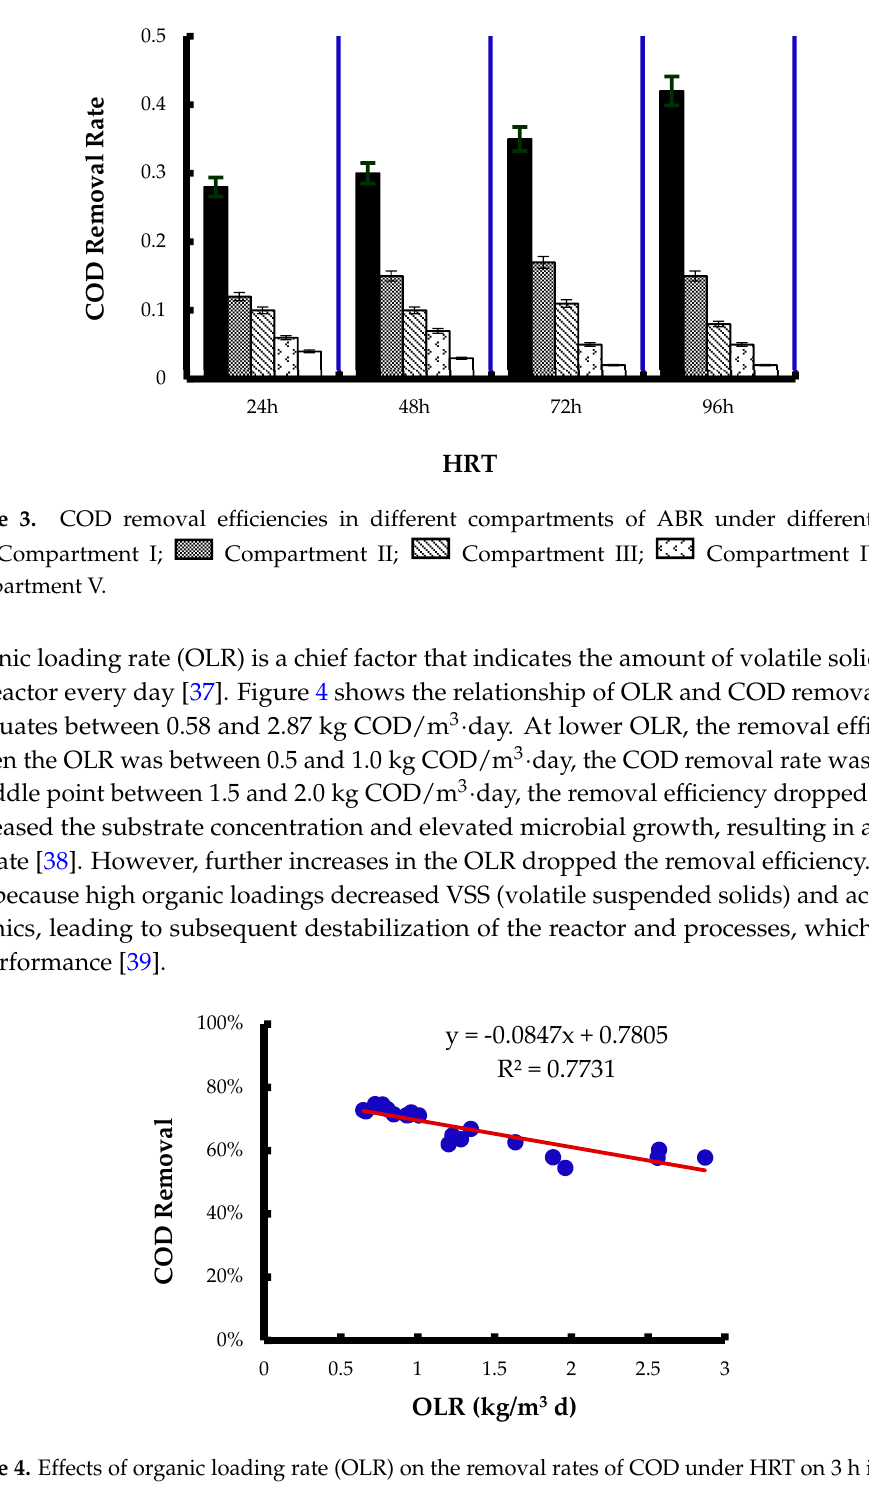
Figure 4. Effects of organic loading rate (OLR) on the removal rates of COD under HRT on 3 h in ABR.